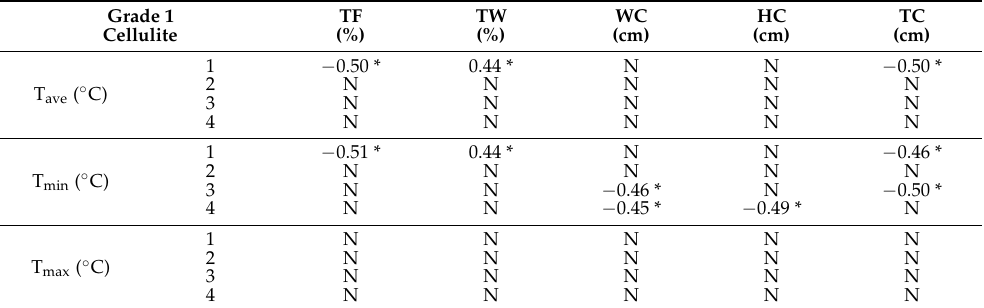
Table 7. The values of the Pearson correlation r coefficient calculated between the values of the surface temperature of the buttocks and thighs and selected parameters of body composition and circumferences in women with grade 1